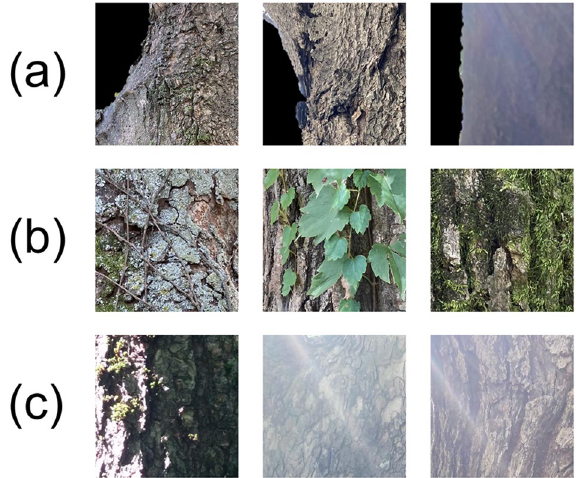
Figure 4. Bark image samples misclassified from the CNN models. ( a – c ) Represent typical conditions in which the CNN models showed the most